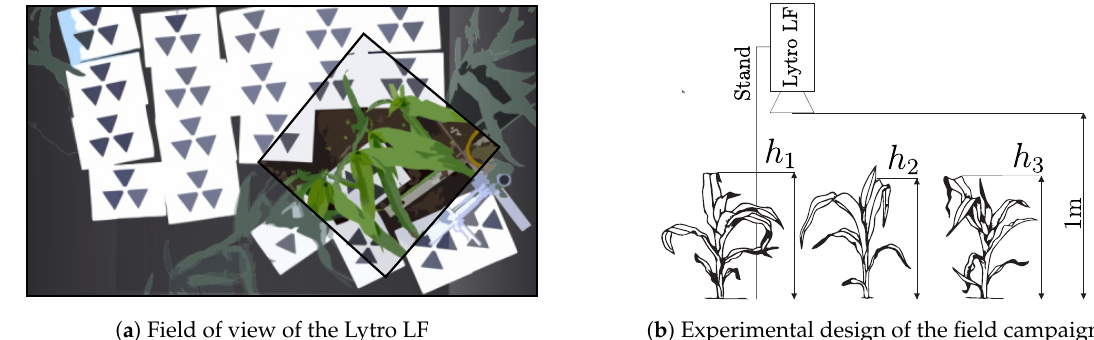
Figure 11. On-site crop growth monitoring: field of view of the Lytro LF and experimental design. ( a ) Field of view of the Lytro LF camera during the field experiment; ( b ) Experimental setup and reference points for the manually plant height